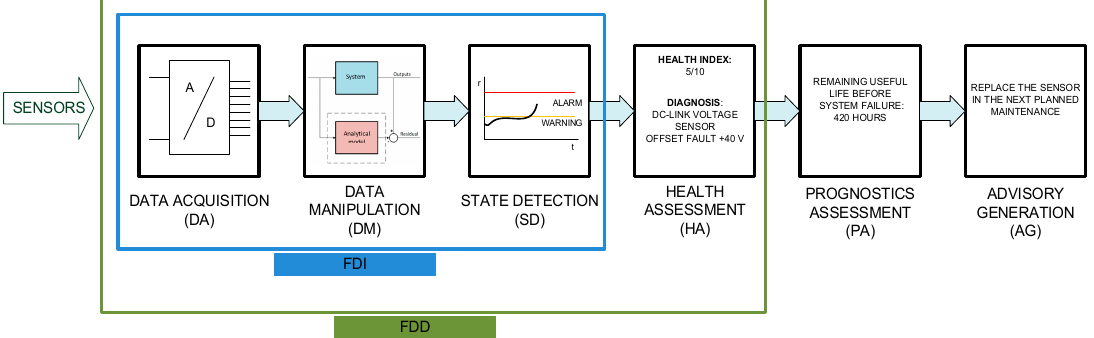
Figure 1. Example of the ISO 13374 functionalities for a condition ‐ based maintenance (CBM) in sensors.